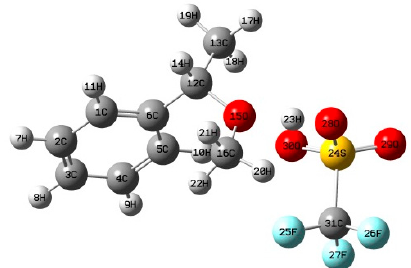
Figure 4. Formation of a hydrogen bond in Int2 between the species Int1 and TfOH.